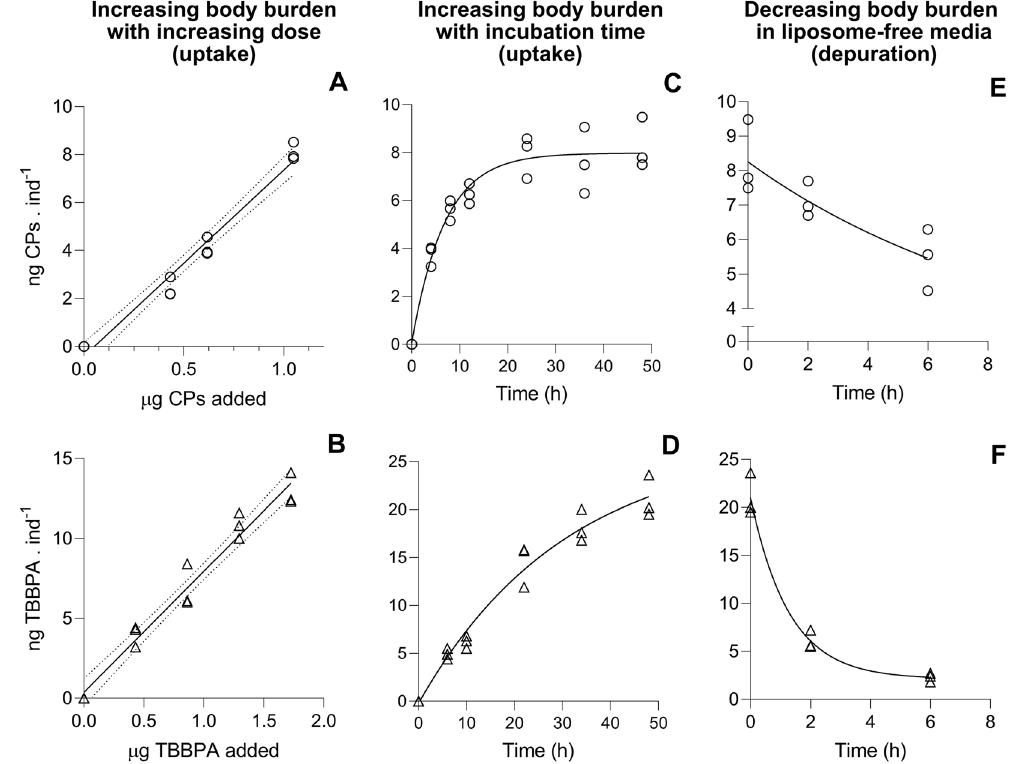
Figure 2. Variation of body burden (ng CPs (top) or TBBPA (bottom) per individual D. magna ) at different doses and over time. A and B: Linear regression for the body burden as a function of the amount of chemical added ( μ g added) to the system via liposomes after 48 hours incubation ( µ = × + − ng ind a g added b 1 ; R 2 = 0.97 for both regressions, Supplementary Table S3) with the 95% confidence intervals of the regression dotted; C and D: increase of body burden over time (between 4 and 48 hours of incubation with chemical- loaded liposomes) at constant chemical dose (1.1 μ g CPs and 2.2 μ g TBBPA via liposomes) and constant liposome concentration of 0.5 × 10 5 liposomes mL − 1 . Data was fitted with an exponential plateau model 1 R 2 = 0.94 for CPs, R 2 = 0.97 for TBBPA, Supplementary ( = − − × − − − ng ind Plateau Plateau ng ind e ( ) ; kt 1 0 Table S4); E and F: decrease of body burden in D. magna after being moved to liposome and chemical free M7 media, with 1 mg L − 1 cellulose (after 48 hours incubation with 1.1 μ g CPs and 2.2 μ g TBBPA via liposomes). Data was fitted with an exponential (one-phase) decay model 1 ( = − × + − − − ng ind ng ind Plateau e Plateau ( ) ; kt 1 0 Table